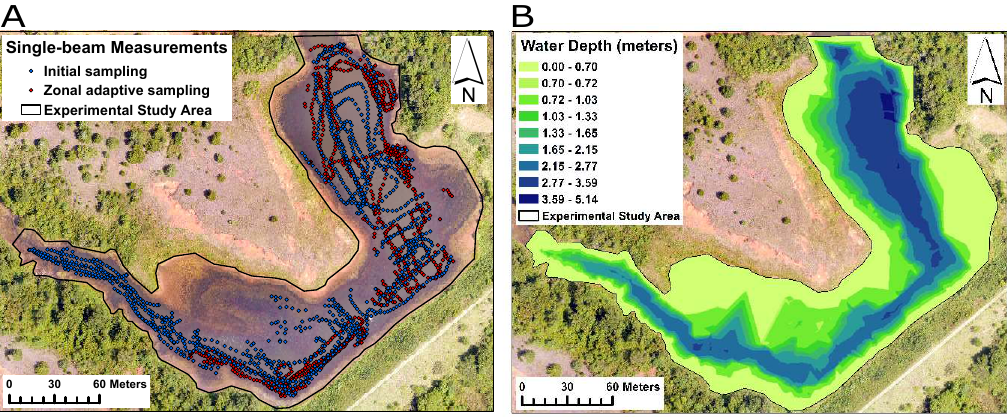
Figure 3. Echosounding sampling and bathymetry of Finn Creek 21 Reservoir in August of 2017. ( A ) initial (blue) and zonal adaptive (red) point sampling; ( B ) interpolated bathymetry using a nearest neighbor technique. Both figures overlay an orthophoto created from the Structure from Motion-photogrammetry.